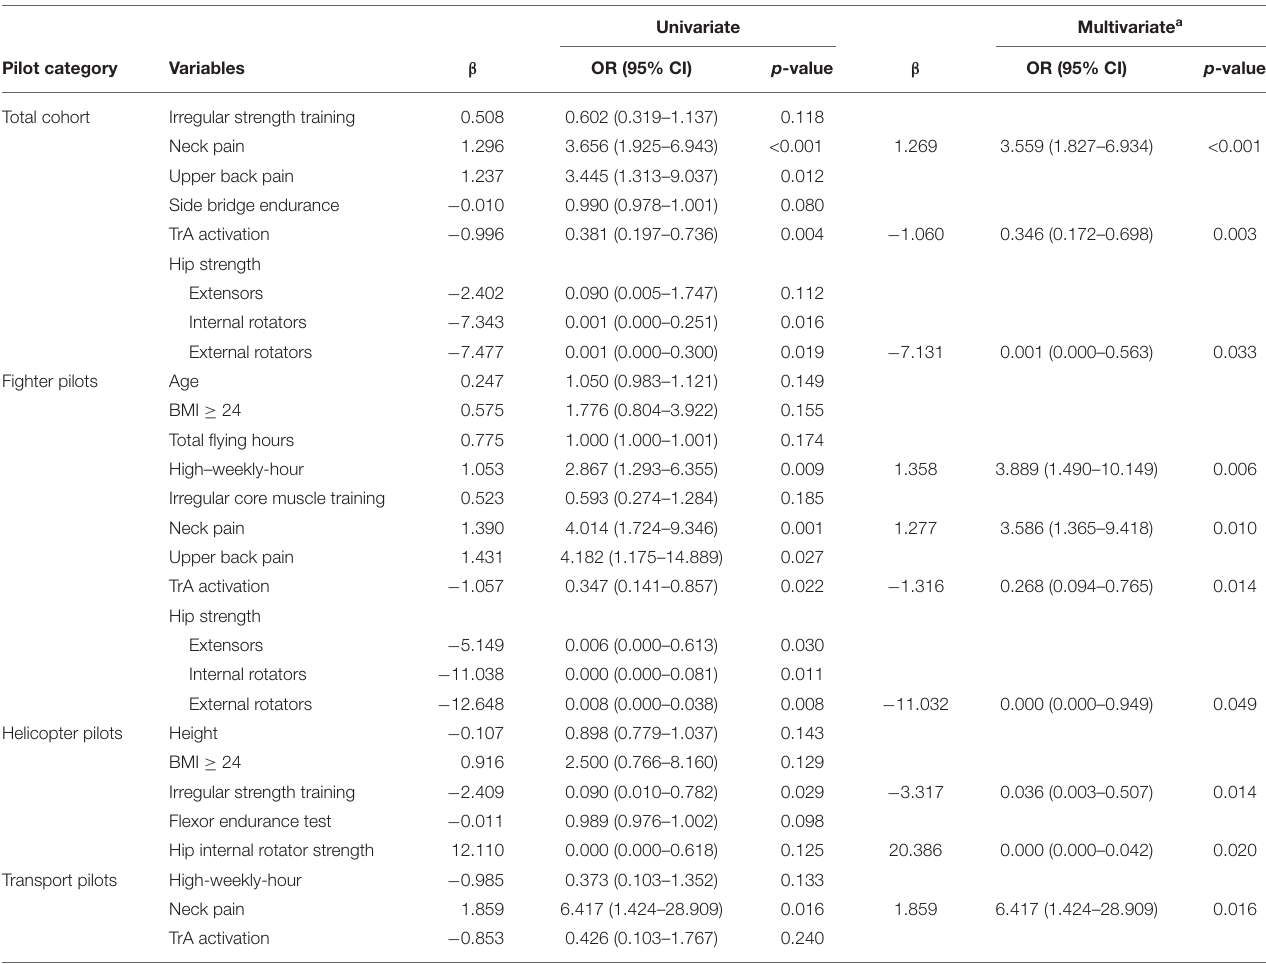
TABLE 3 | Risk factors for low back pain in the study population.